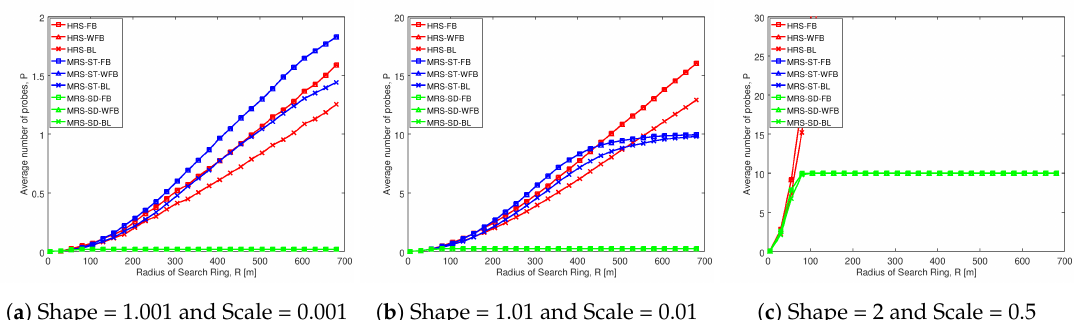
Figure A5. Average probe number comparison of various schemes in different social trust scenarios when network width is 1000 m.